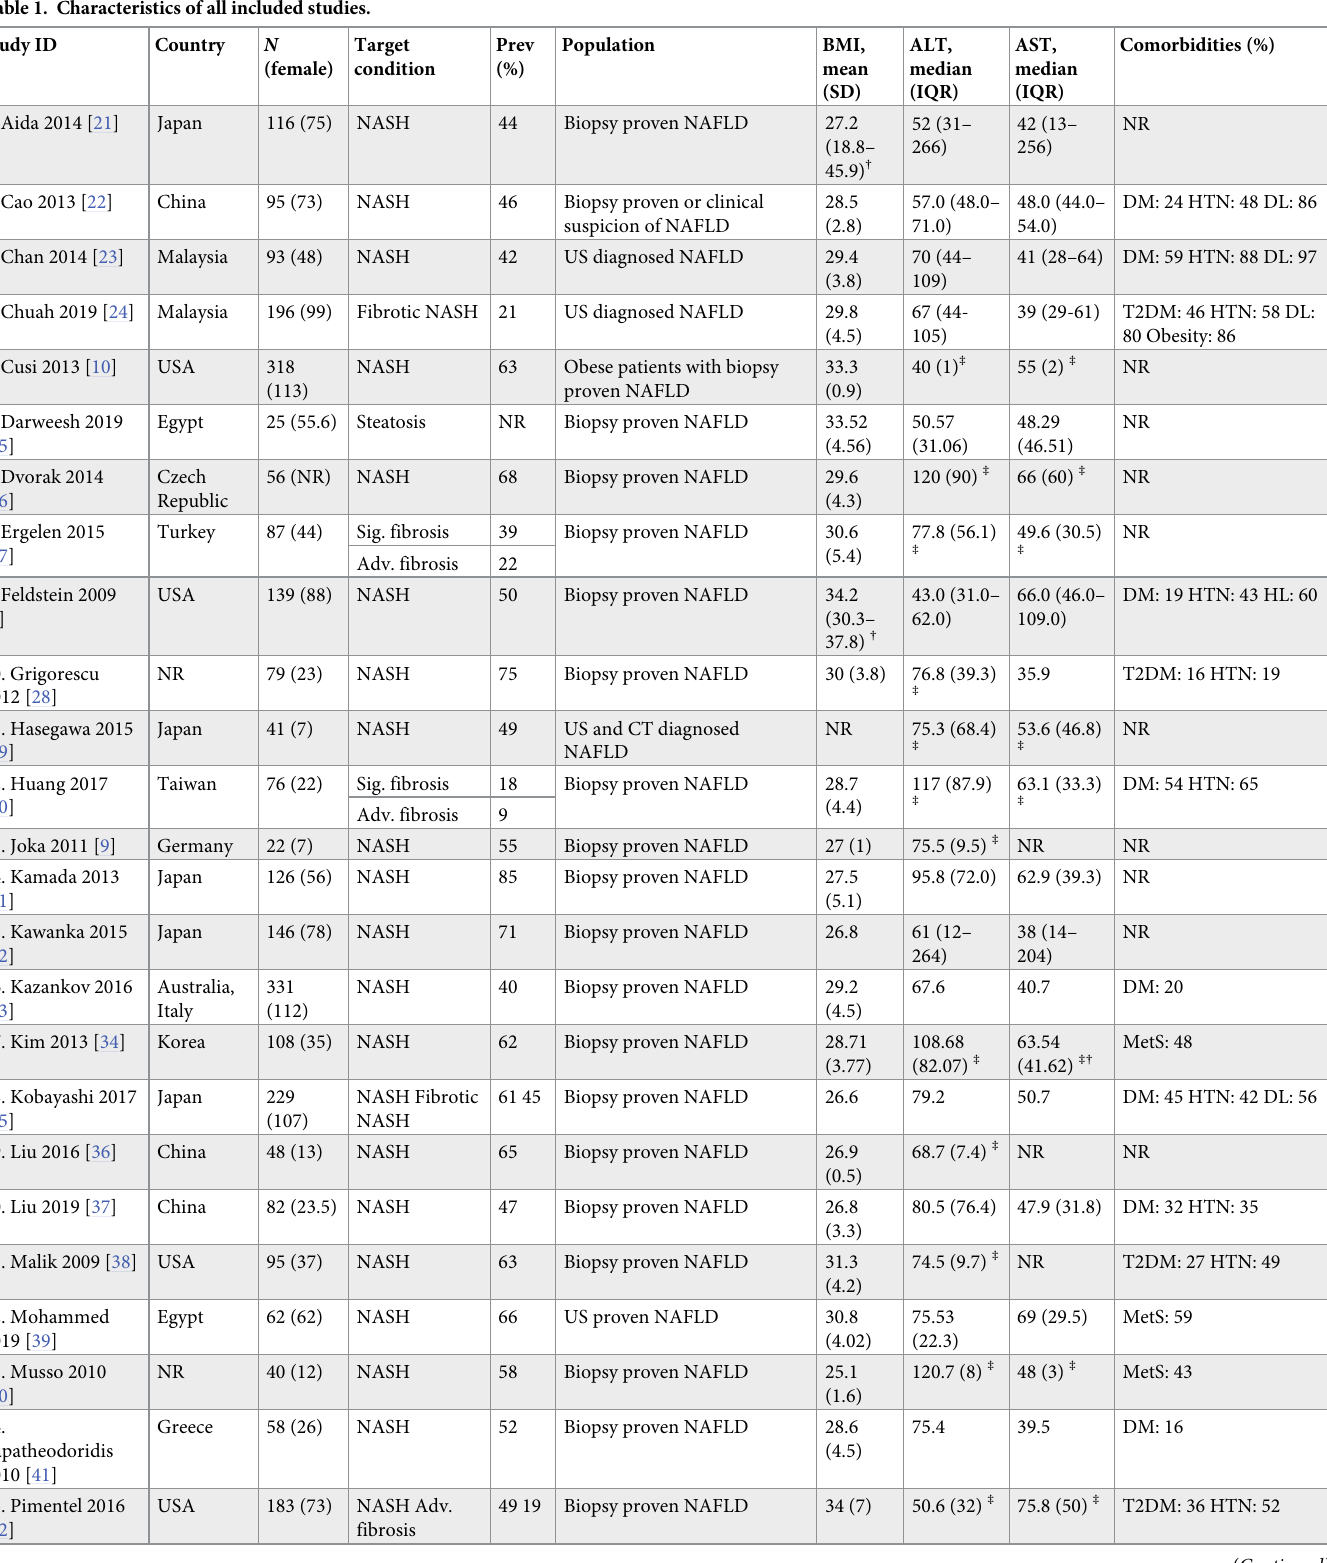
Table 1. Characteristics of all included